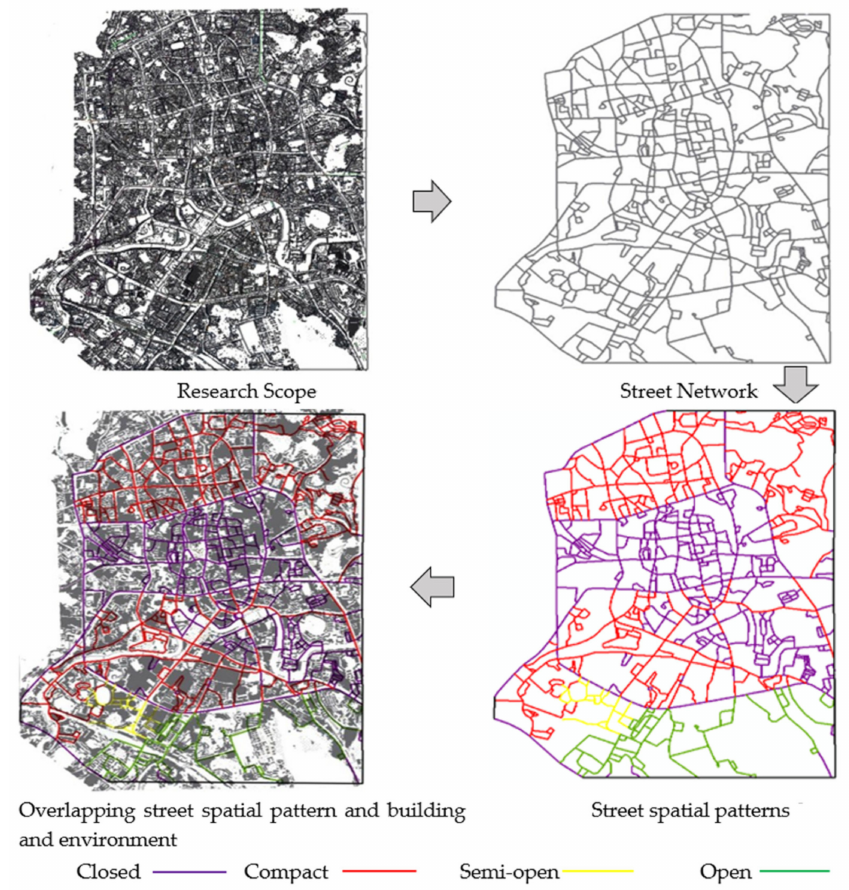
Figure 3. Process of street space